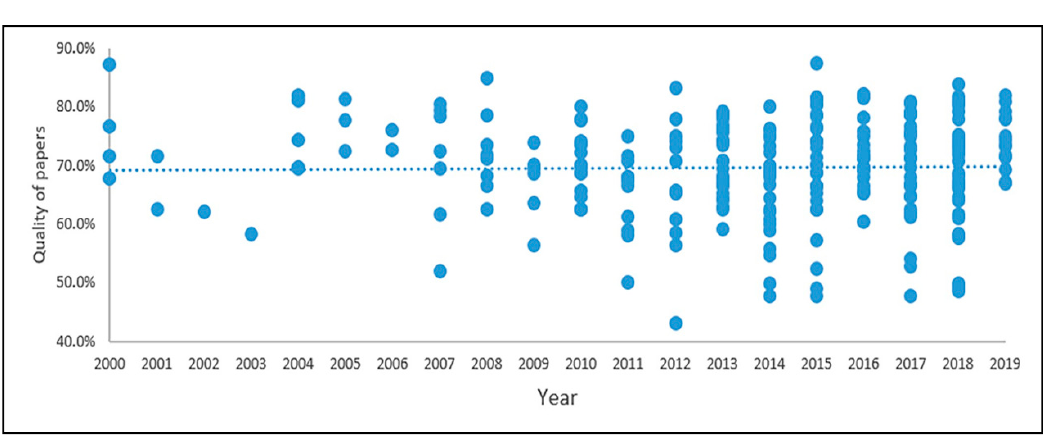
Figure 10. Quality assessment of the reviewed papers (legend: good quality > 80%, 80% > medium quality > 70%, 70% > bad quality > 65%, 65% > very bad quality).